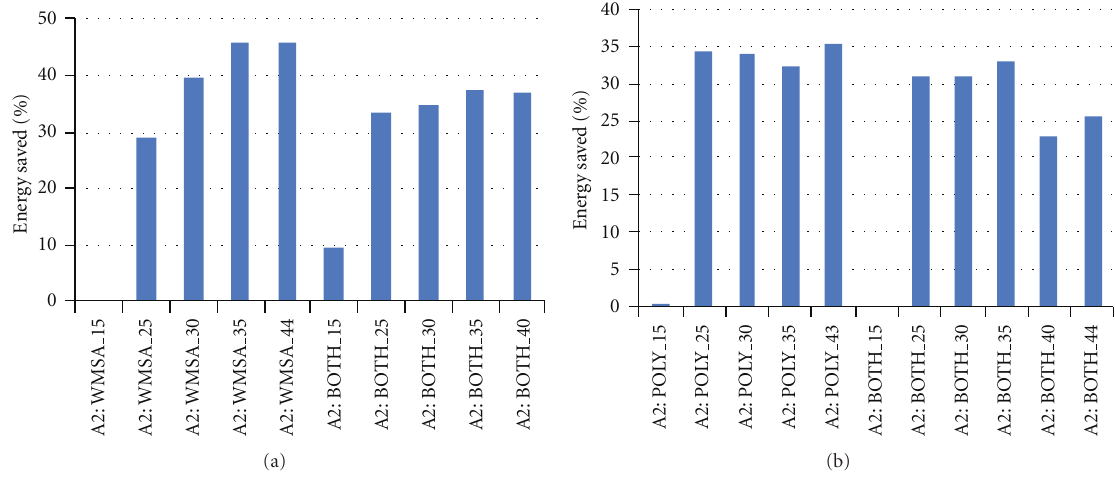
Figure 15: 64-bit: dedicated A2 versus hybrid A2 energy consumption normalized to worst case. WMSA (a) and PI